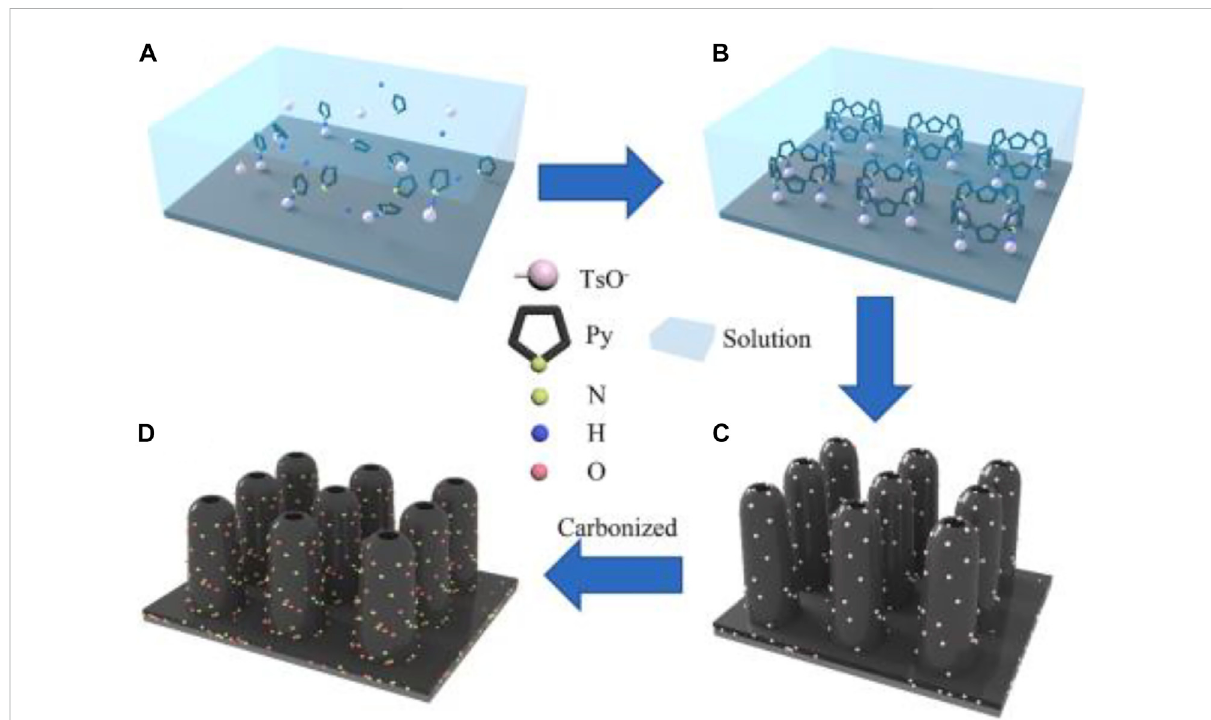
FIGURE 17 Growth process of carbon paper-based NAs: (A) ionization and adsorption of pyrrole and TsOH in an aqueous solution; (B) under an electric fi eld,pyrroleandTsOHadsorbedeachotheronthecarbonpaper,resultinginanorientedarrangementandoxidizedchain, fi nallyformingnucleation growth sites; (C) electrodeposition of PPy NAs; and (D) carbonization to obtain D-CNAs (Liu et al., 2022).